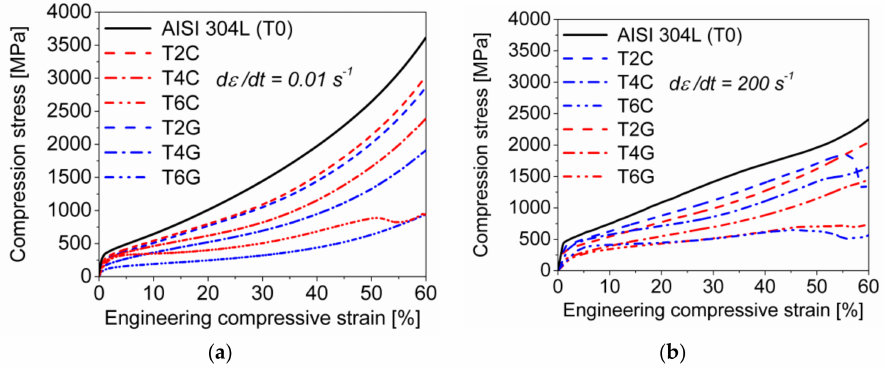
Figure 4. Engineering stress-strain curves of the TRIP-steel bulk specimens and the syntactic foams with S60HS glass microspheres or Fillite 106 cenospheres under ( a ) quasi-static (0.01 s − 1 ) and ( b ) dynamic compressive loading (200 s − 1